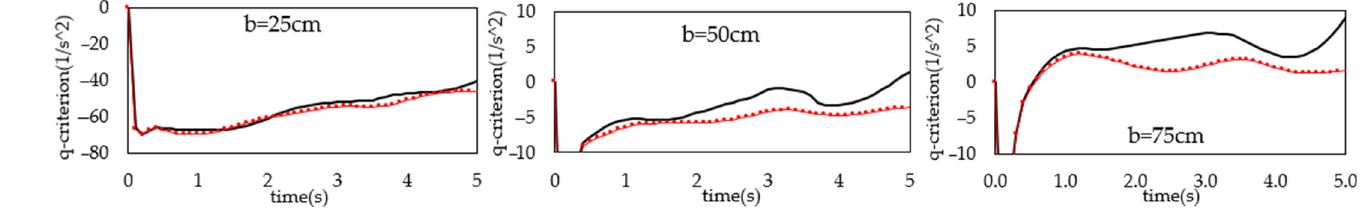
Figure 13. Near–bed q –criterion at the center of dam gate. Solid line–asymmetrical dam gate; dot line–symmetrical one